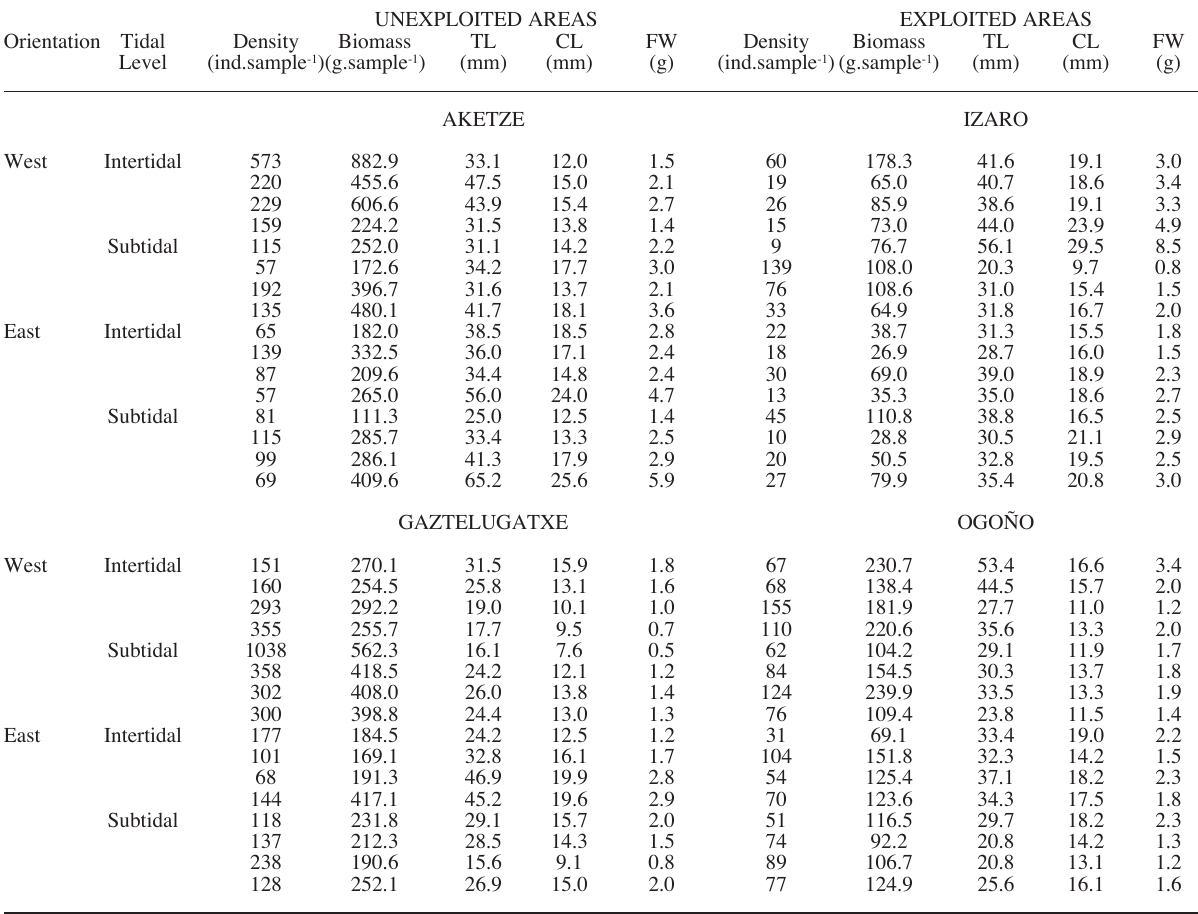
T ABLE 2. – Comparison of density, biomass, capitulum length and total length: (a) between protected and non-protected areas, for each ori- entation and tidal level; (b) between tidal levels for protected and non-protected areas, for each orientation; and (c) between orientations, for protected and non-protected areas and each tidal level. Kruskal-Wallis (K-W) and Kolmogorov-Smirnov (K-S) statistical and p-values are presented, for each comparison. Significant differences (p<0.05) are underlined. (-) A non-orthogonal test was not undertaken,